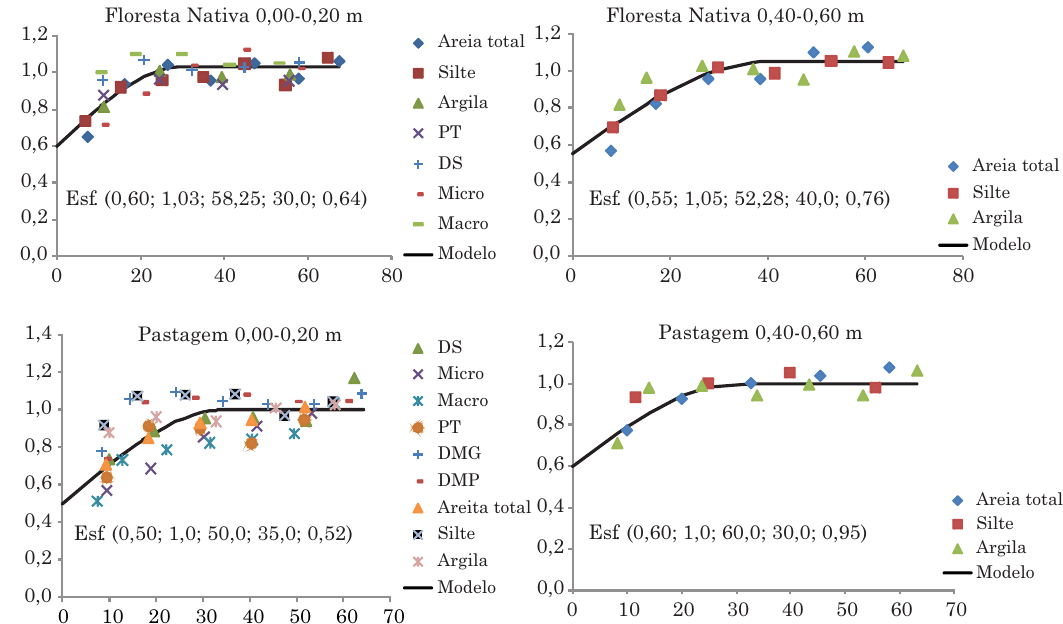
Figura 2. Semivariogramas escalonados para os atributos físicos em área de floresta nativa e pastagem na região sul do